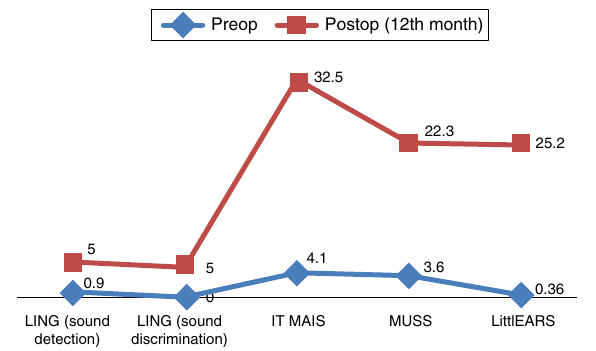
Results of auditory perception skills scores in ANSD with CI.